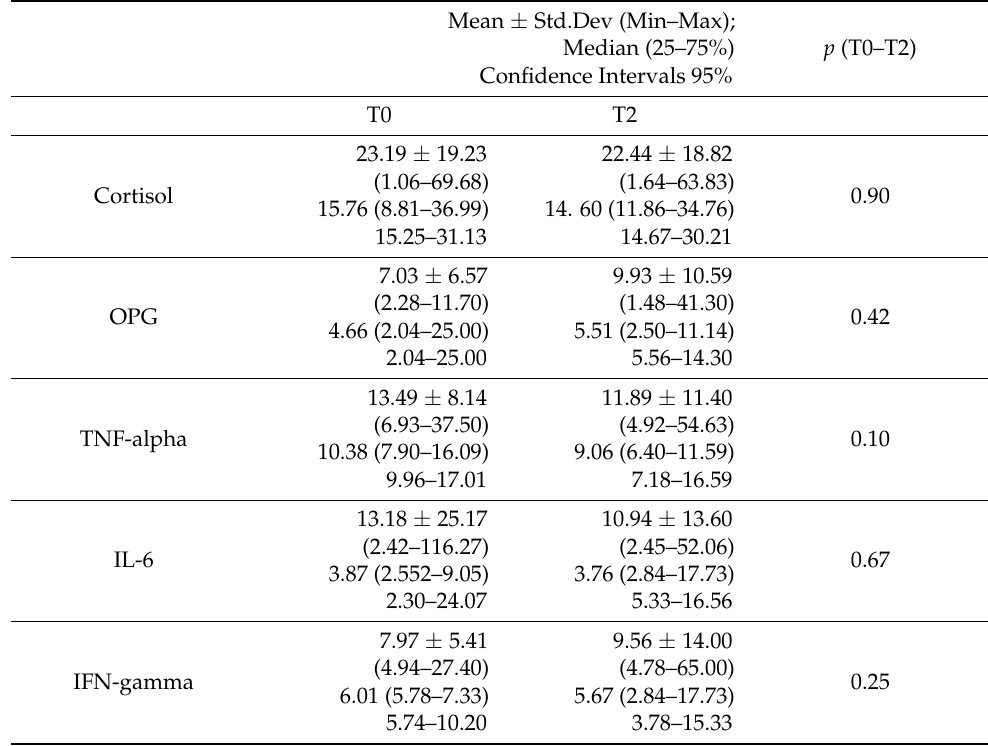
Table 2. Dynamics of salivary cytokine levels (mean ± std.dev (min–max), median (25–75%), and confidence intervals 95%) in patients treated with conventional brackets